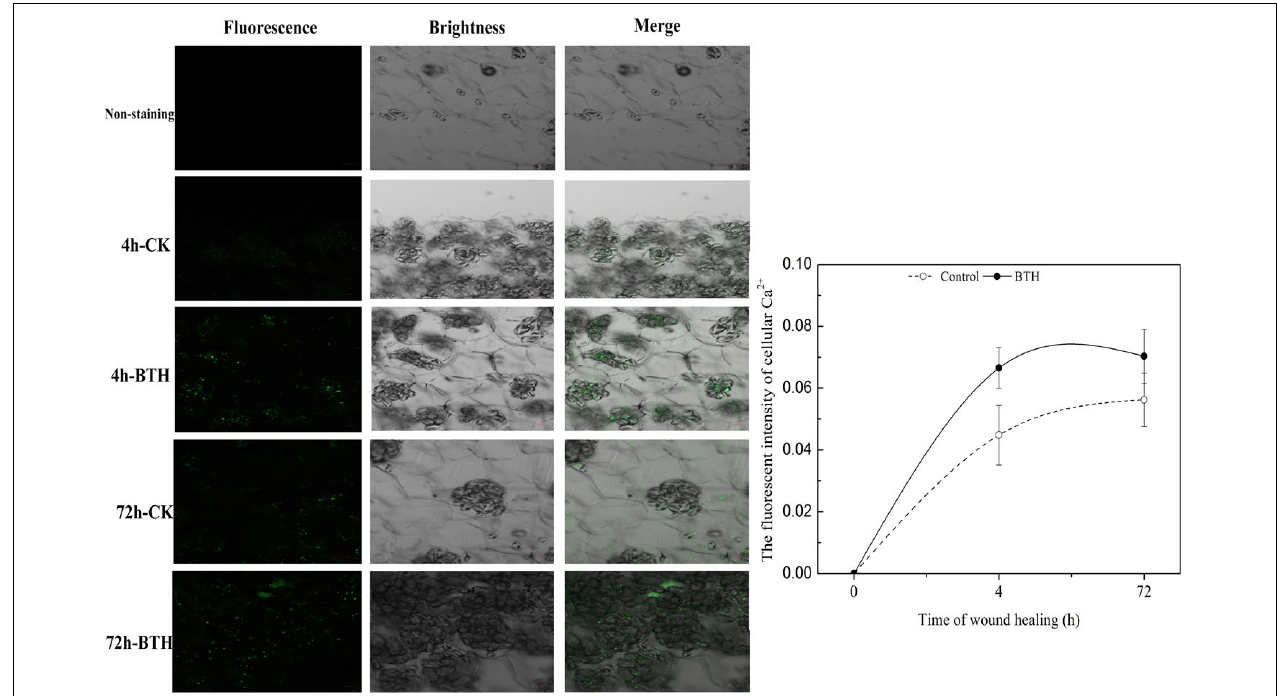
FIGURE 2 | Fluorescence of cytosolic Ca 2 + in benzo-(1, 2, 3)-thiadiazole-7-carbothioic acid S-methyl ester (BTH)-treated tissues of potato tuber at 4 and 72 h of healing. Bar = 50 µ m.